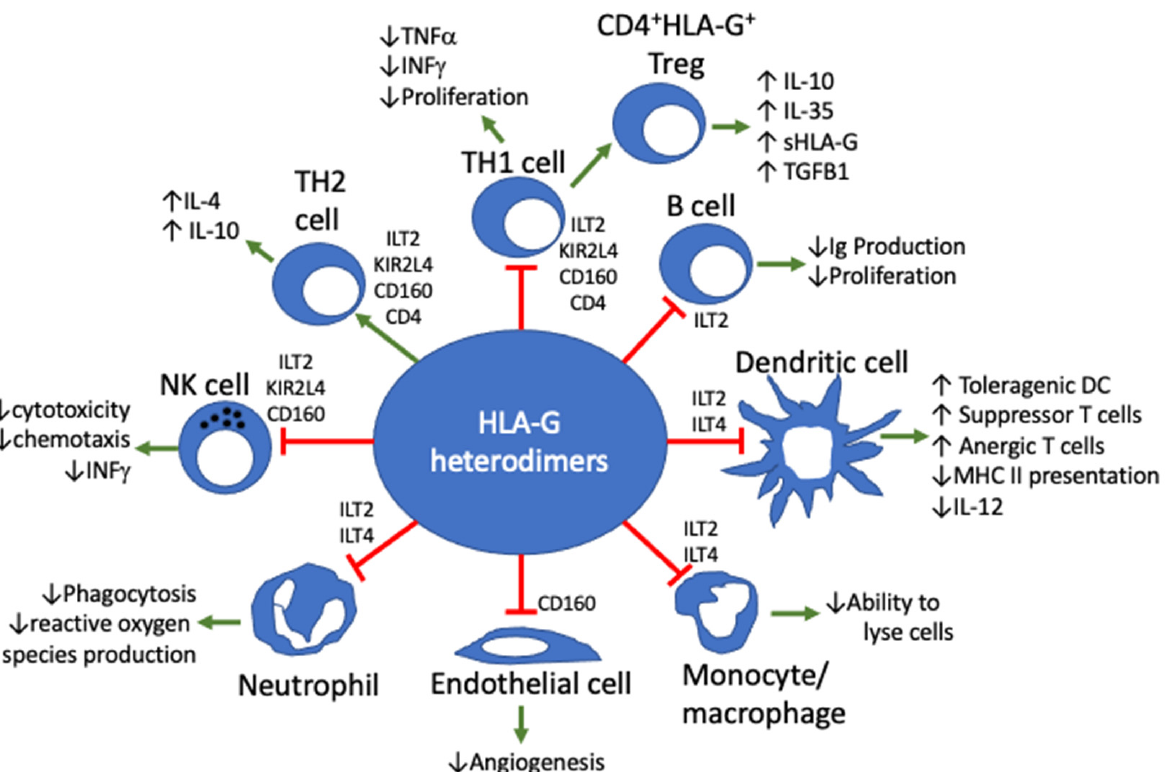
Figure 1. HLA-G actions on various cell types. Cellular receptors and cell activity following HLA-G binding are listed for each cell type. ( ↑ = increased; ↓ = decreased).